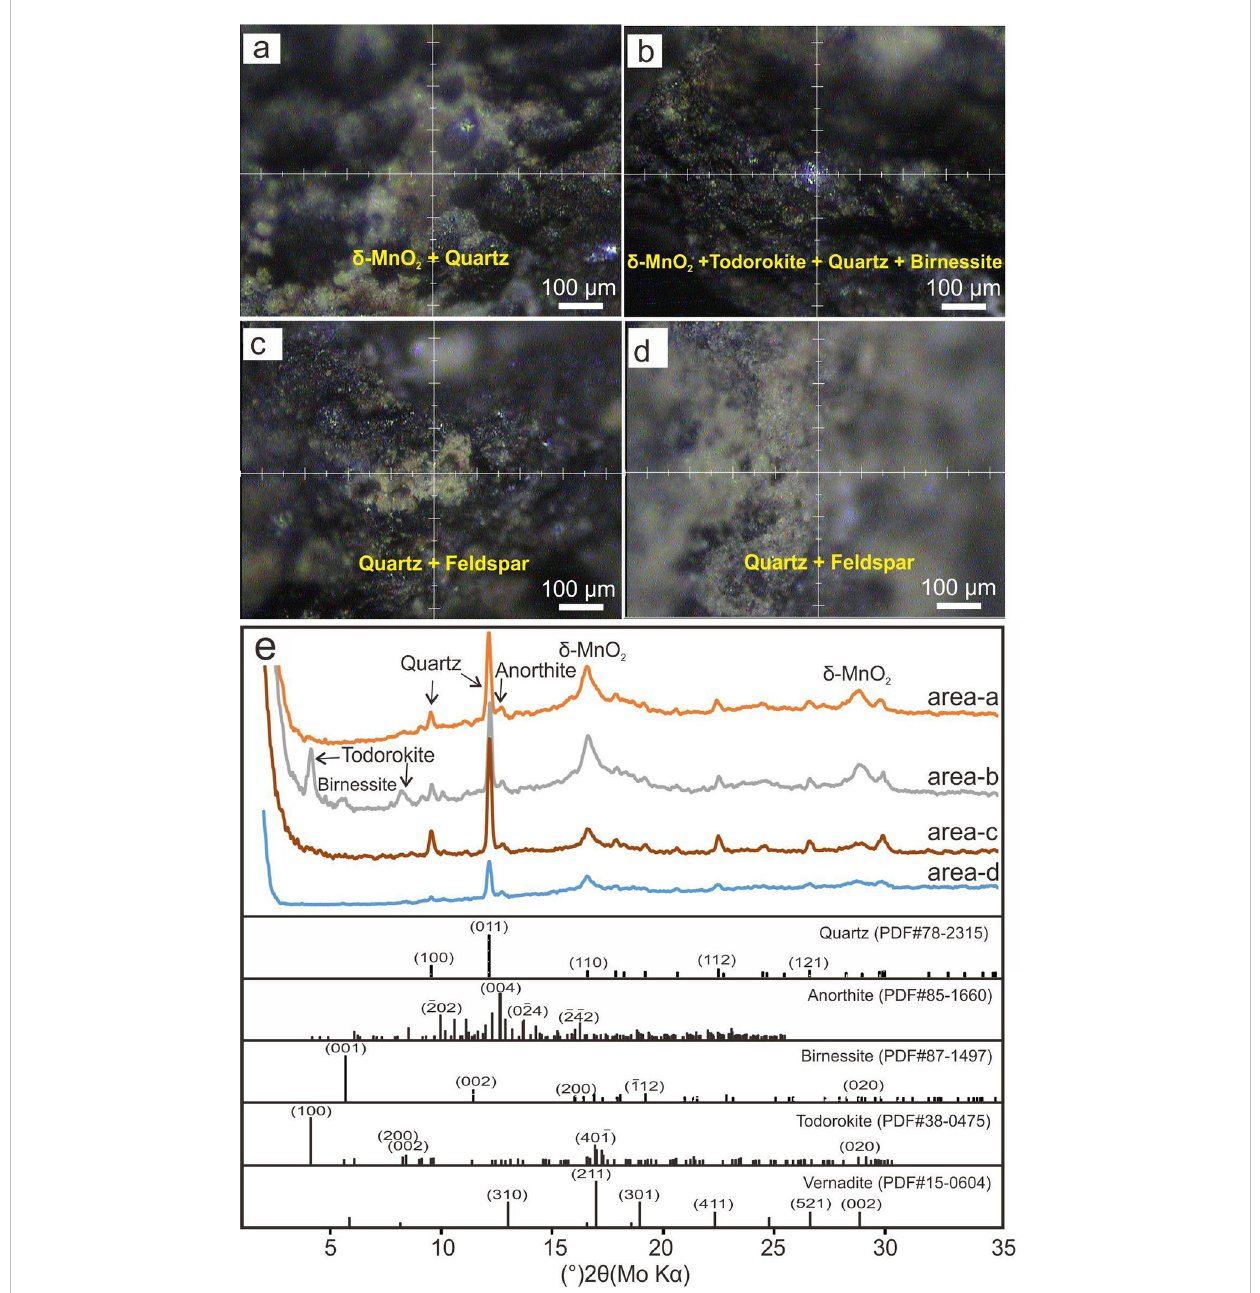
FIGURE 6 In-situ micro-XRD patterns of sample ST1. (A, B) Mn minerals including d -MnO feldspar. (E) XRD patterns of area